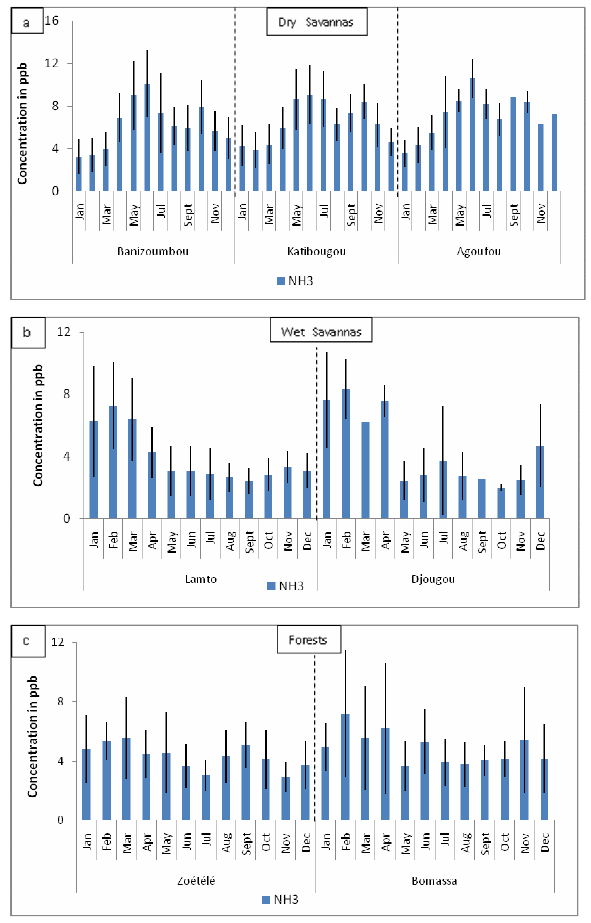
Figure 8 : Evolution of monthly NH 3 concentrations on the transect dry savannas (8a), wet savannas Fig. 8. Evolution of monthly NH 3 concentrations on the transect (8b), forests (8c). dry savannas (a) , wet savannas (b) , forests (c)